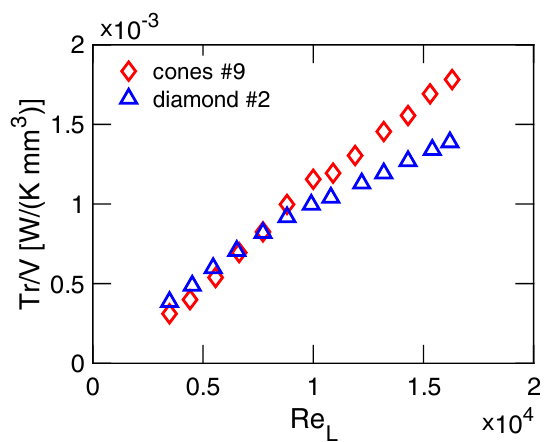
Figure 8. Comparison between the best experimental values of Tr / V for cones (sample 9) and diamonds (sample 2 [46]) micro-protruded heat